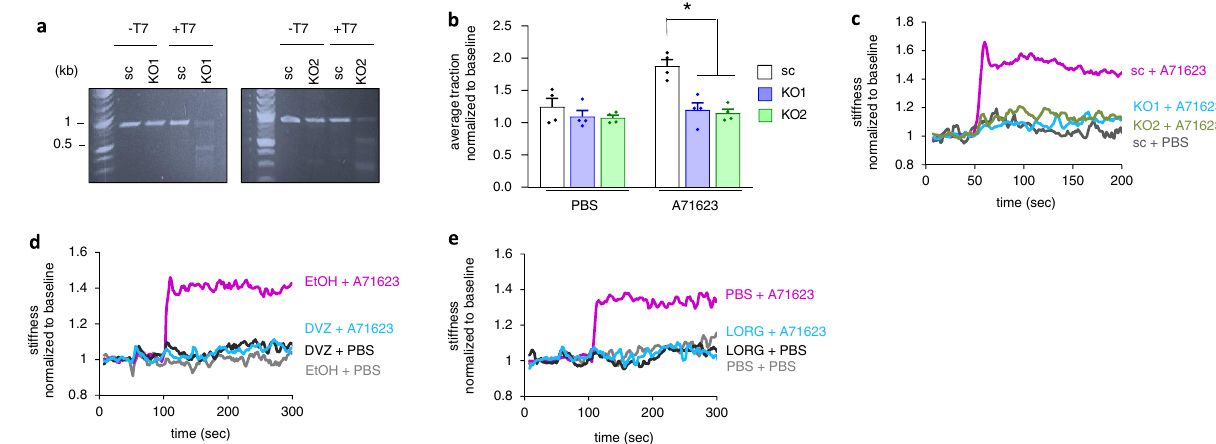
Fig. 2 | CCKAR mediates CCK-induced stiffening and contraction of ASM cells. a T7E1 assay on CRISPR/Cas9-mediated CCKAR knockout ASM cells. CCKAR knockout (KO) cells were generated by lentiviral delivery of gRNAs targeting the CCKAR gene. DNA cleavage indicating mismatch and mutation induced by the two gRNAs targeting CCKAR was detected by T7 Endonuclease 1. Multiple bands in the DNA gel indicate mutation in the CCKAR gene in KO cells (KO1 and KO2). b TFM- basedcontractility measurement in controlvs. CCKAR -KOASMcellsinresponseto A71623 treatment (10nM). Data are presented as mean±SEM; n =4 biologically